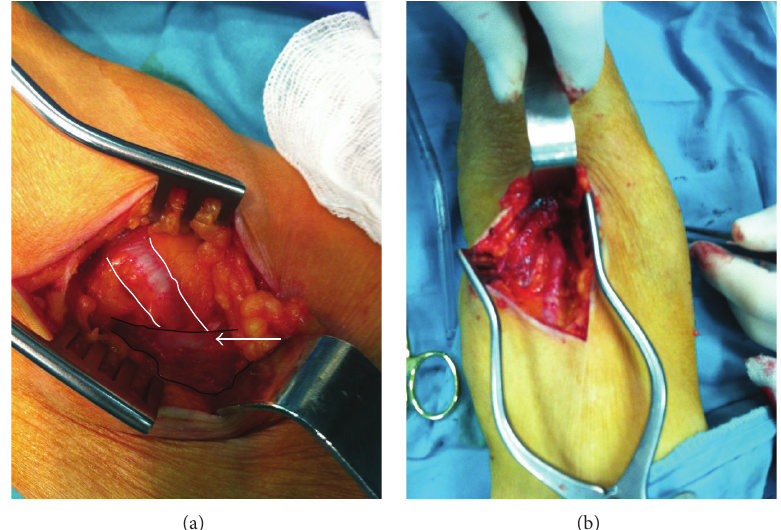
Figure 1: (a) The brachial artery (white borders) seen piercing through and entrapped by the bicipital aponeurosis (white arrow shows the aponeurosis—dark borders). (b) The brachial artery liberalized by resecting the aponeurosis.